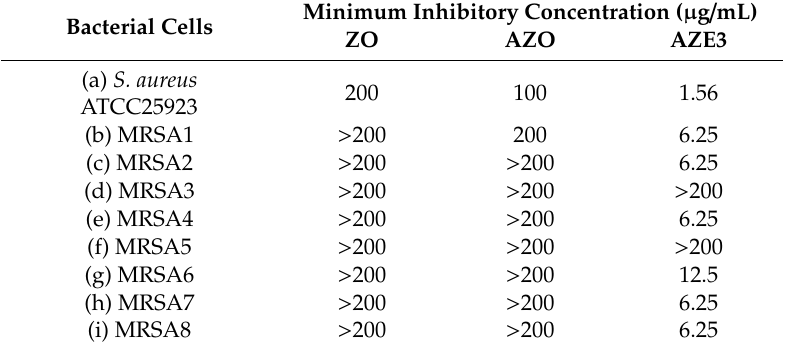
Table 3. Minimum inhibitory concentration (MIC) of ZO samples against (a) S. aureus and (b–i) MRSA1 to 8. Data shown are representative from n =